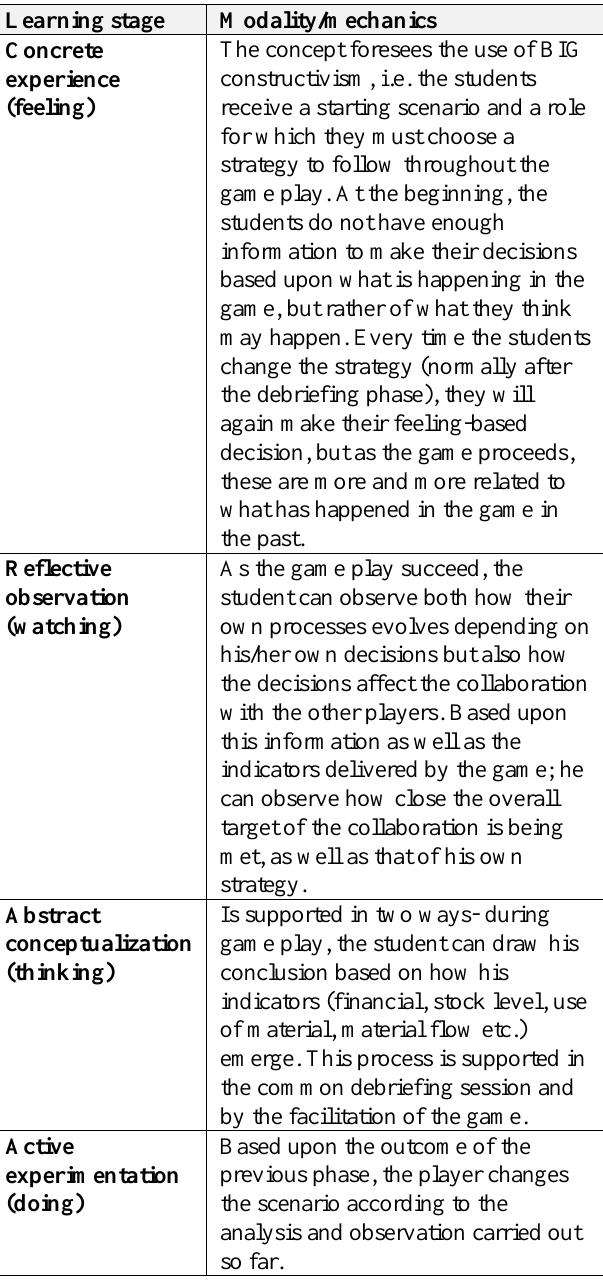
Table 7 : Support of Kolb’s learning cycle due to the BIG approach Learning